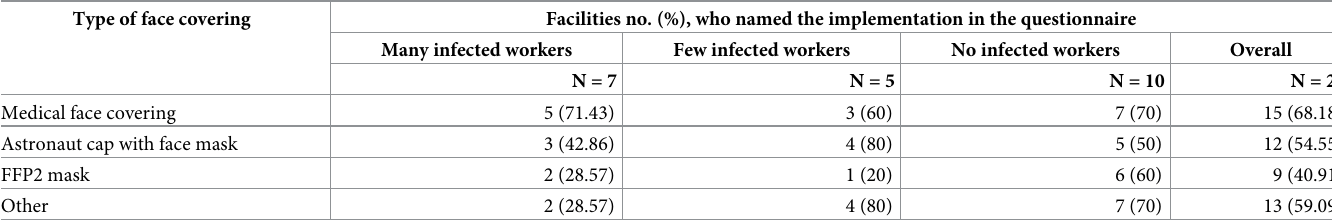
Table 2. Type of face covering by facilities in response to SARS-CoV-2 in 22 meat and poultry processing facilities—June–September 2020. Type of face